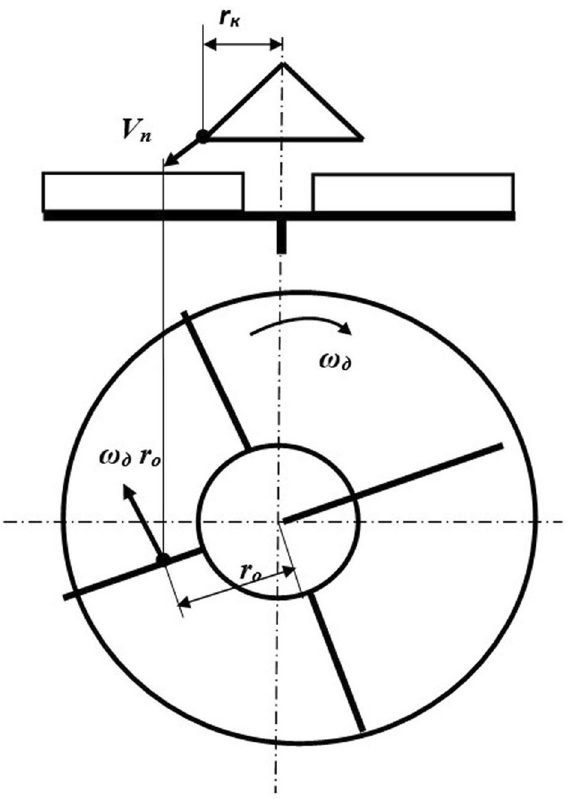
Figure 1. Analysis of the process of interaction of the seeds with the blades of the centrifugal disk. Source: author’s development.